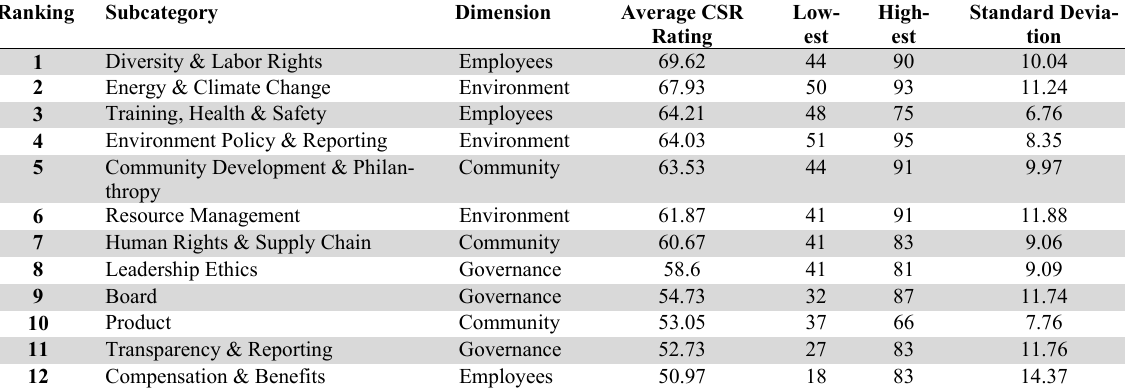
Ranking of Subcategories with Average CSR Rating